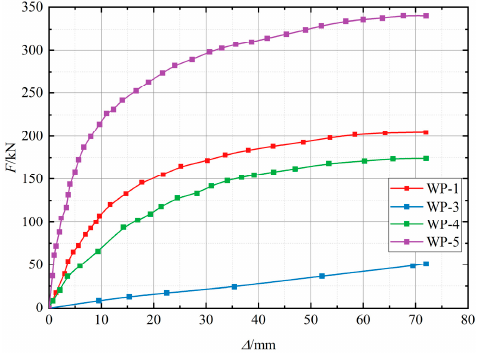
Figure 21. The load–displacement curves of the FE models.